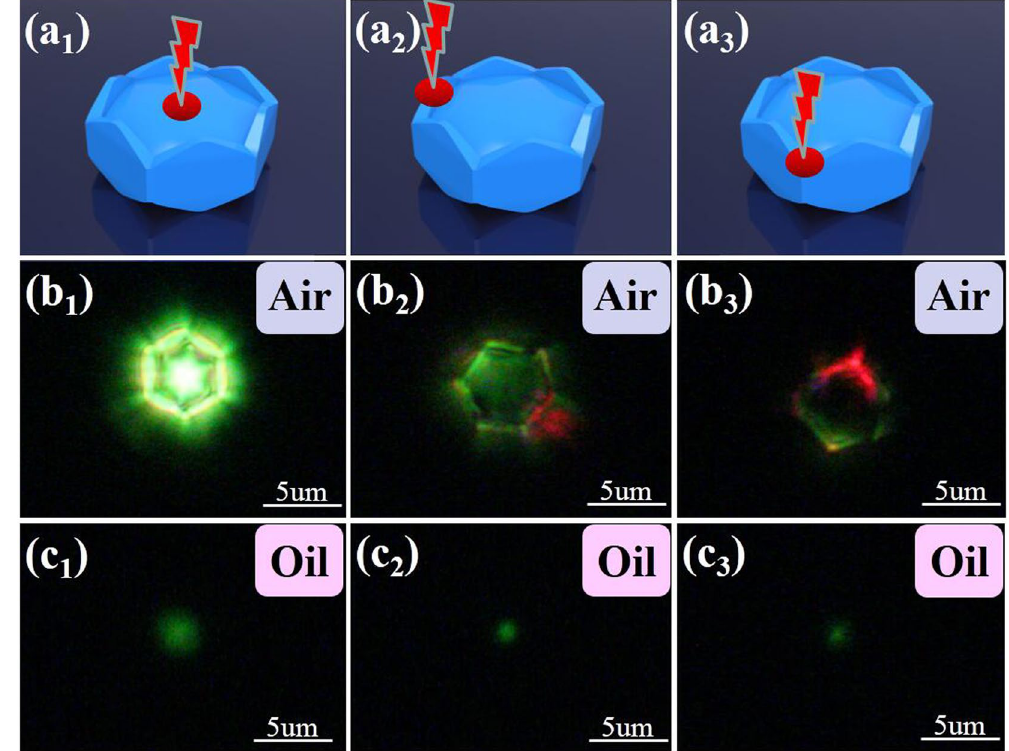
Figure 4. Sample illustration and UC luminescence emission of PS β HM dispersed in different surrounding medium. ( a 1 ) to ( a 3 ) Specific location of the excitation light. ( b 1 ) to ( b 3 ) Typical UC luminescence emission observed with corresponding location of the excitation light when the sample particle is in the air. ( c 1 ) to ( c 3 ) Typical UC luminescence emission observed with corresponding location of the excitation light when the sample particle is in the microscopy oil. The refractive index of air, microscopy oil and NaYF 4 medium are 1.00, 1.59 and 1.43,